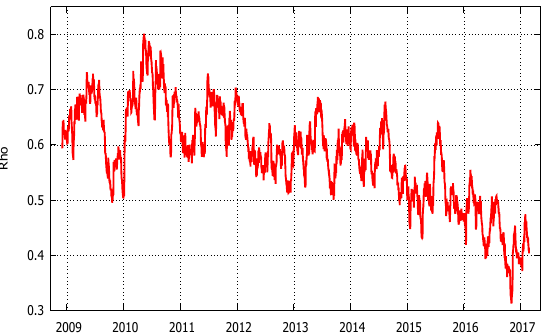
Figure 2. The figure exhibits the time-varying spatial spillover, ˆ ρ t